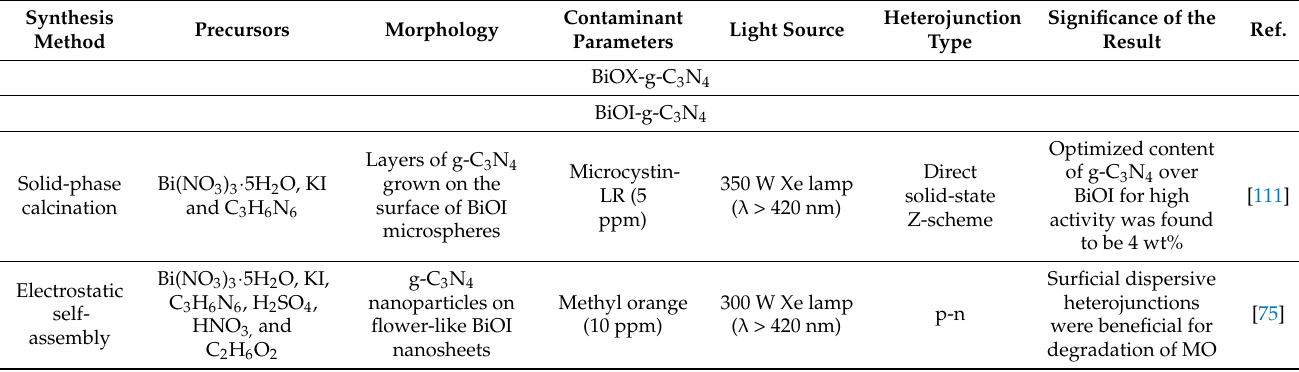
Table 1. Summary of the degradation of organic contaminants in the presence of BiOX/Bi x O y X z -g-C 3 N 4 heterojunction photocatalysts reported in the literature.